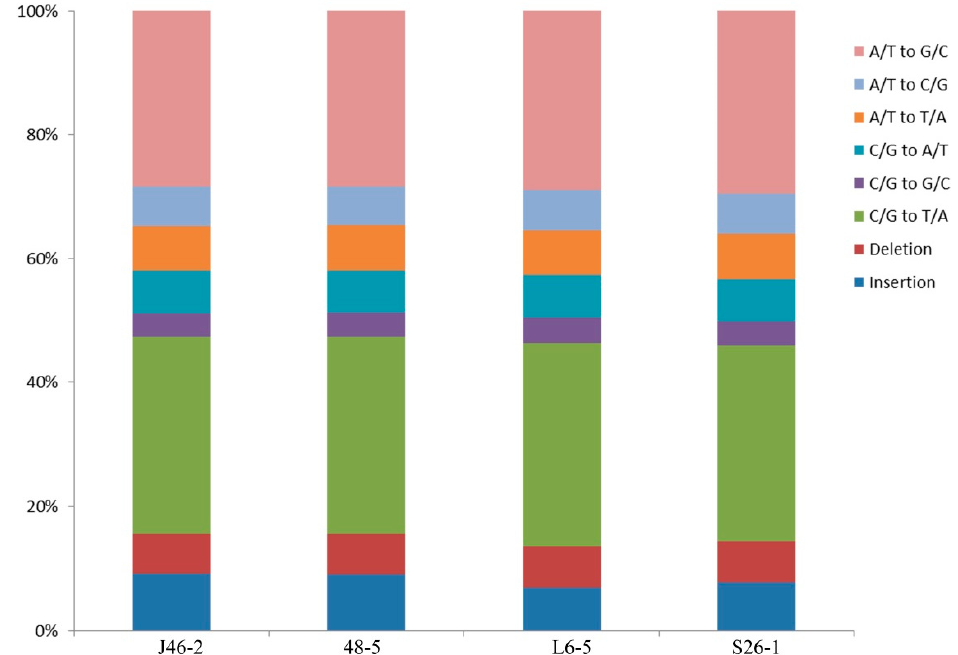
Figure 2. Genome wide analysis the proportions of SNPs mutations in the four ethyl methanesulfonate-induced eggplant mutants.